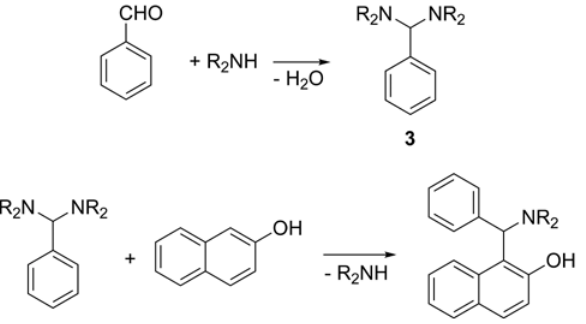
Scheme 5. Reaction with a secondary amine.